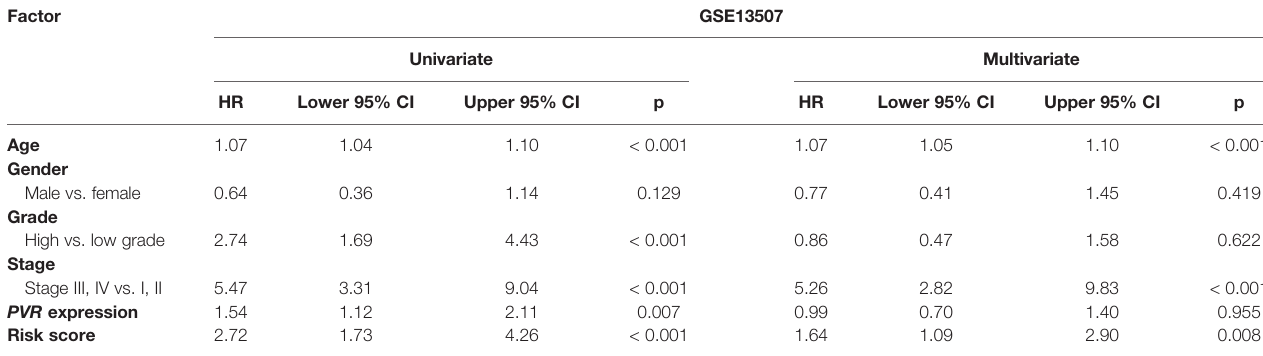
TABLE 4 | Univariate and multivariate Cox analyses in GSE13507 cohort. Factor GSE13507 Univariate